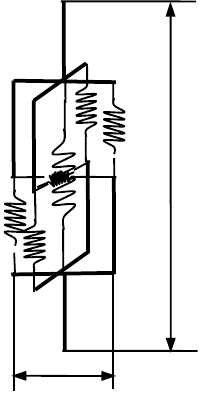
Figure 7. Equivalent rigid beam-spring model.